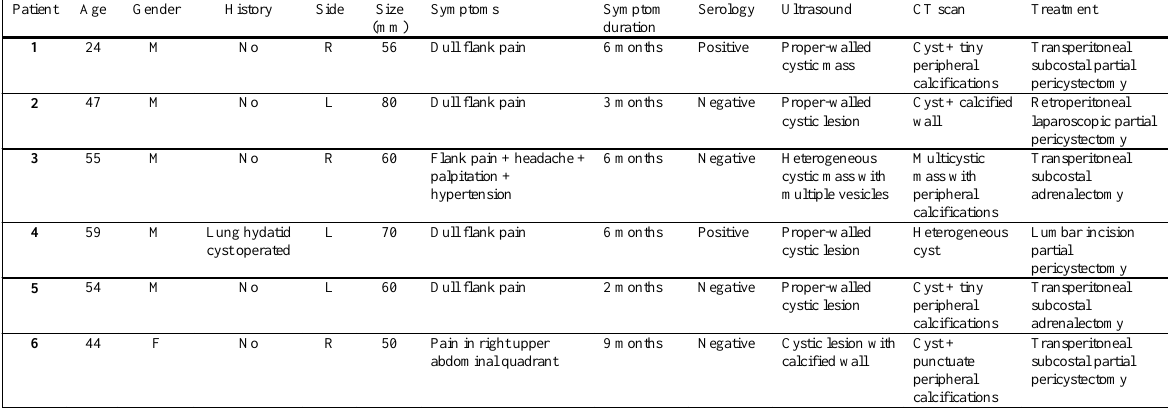
There were five men and one woman and their ages ranged from 24–59 years (median: 47 years). All six patients had unilateral cyst with no other concomitant hydatid localizations. One patient, a 59-year-old man , had undergone an operation 10 years previously for left pulmonary hydatid cyst. All patients had plain abdominal X-ray films, ultrasound, and computed tomography (CT). Indirect hemagglutinin (IHA) test for Echinococcus granulosus was obtained in every case. One patient with symptoms suggestive for phaeochromocytoma had VMA and catecholamine metabolites levels